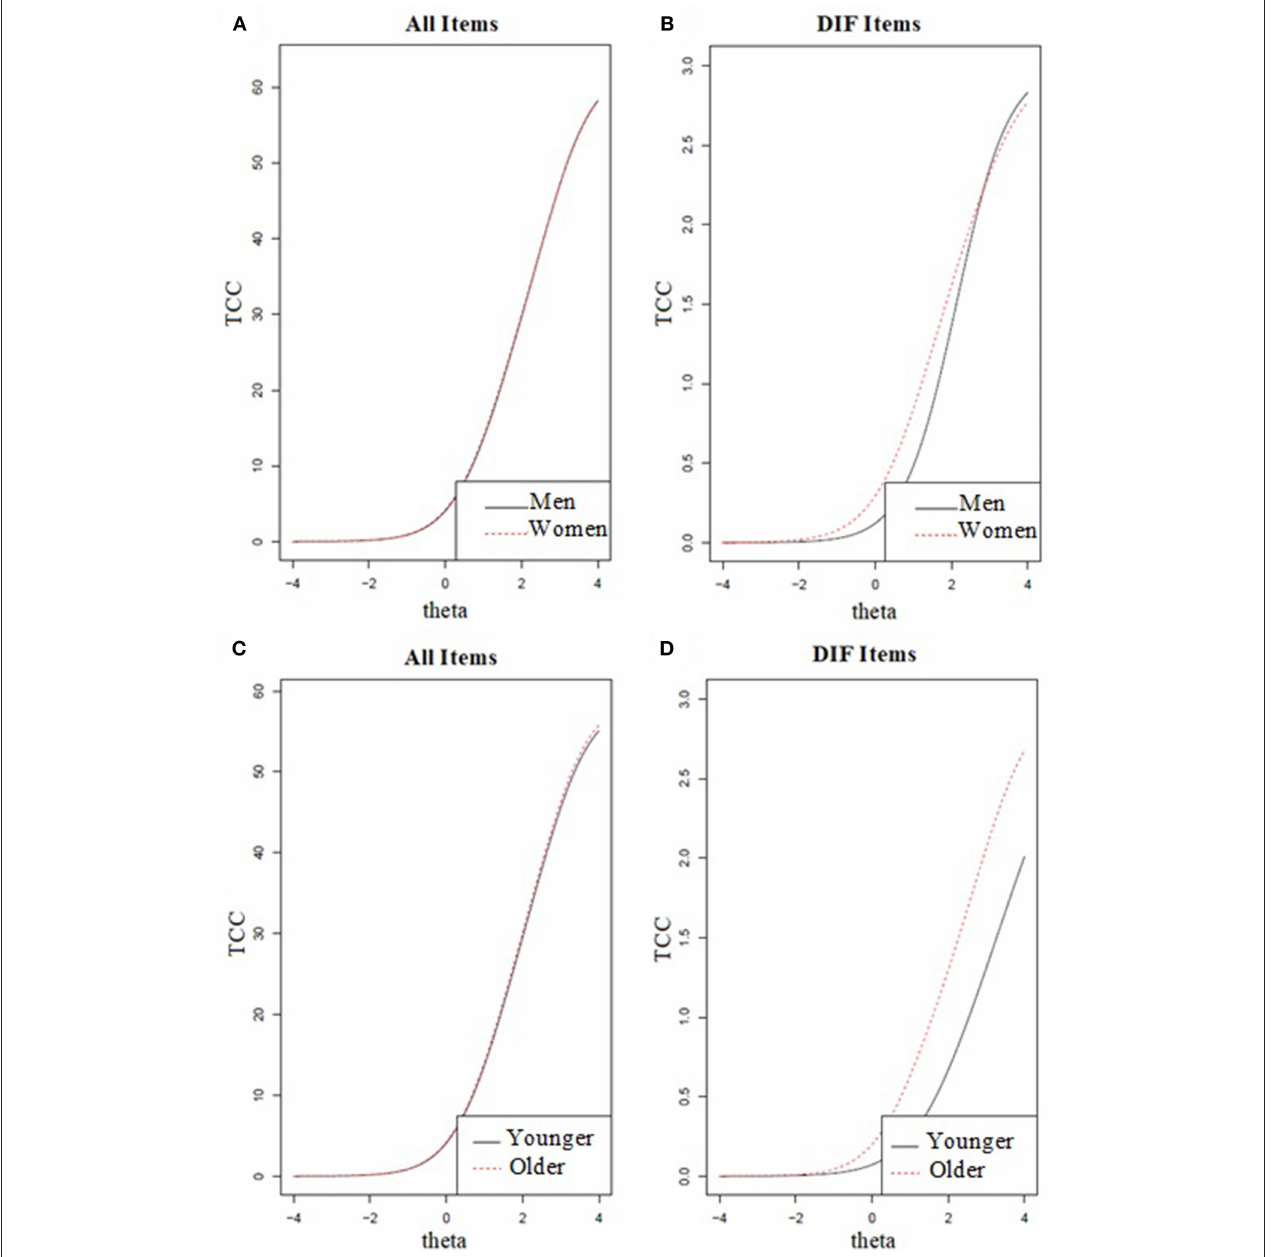
FIGURE 2 | Overall impact of differential item functioning (DIF) for gender and age on the test characteristic curves (TCC). The first (A) and third (C) plots display the TCC of all items and the second (B) and fourth (D) plots display the TCC of specific DIF items (i.e., item #10 for gender and item #21 for